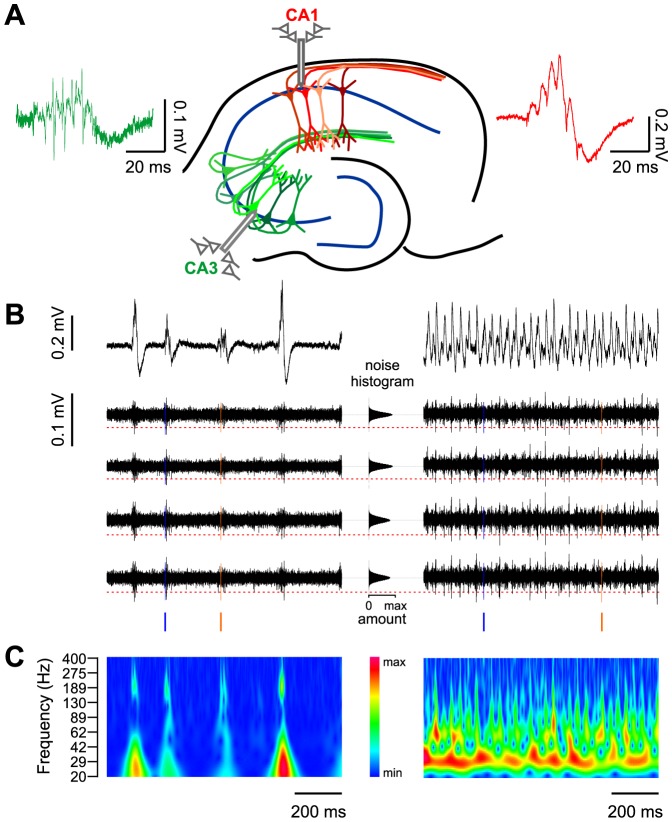
Different network states and corresponding unit activity can be analyzed in the in vitro model.
A: Schematics of recording conditions. Tetrode recordings are performed in the pyramidal cell layers of CA3 and CA1. During sharp wave-ripple oscillations (SPW-R), field potentials are generated by the recurrent network of CA3 (green) and transmitted via the Schaffer collaterals to selectively activate cell assemblies in CA1 (red). Examples of field potential waveforms are shown in the respective colors. B: Example traces of field potentials recorded in CA1 during SPW-R (left panel) and gamma oscillations (right panel). Raw field potential (upper trace) and the high pass filtered (0.5–10 kHz) potential in the four tetrode channels (lower traces). Filtering reveals high-frequency multiunit activity on SPW-R and gamma cycles. Firing of two individual units extracted by waveform analysis is highlighted in orange and blue. Time points of firing relative to the field potential are visualized by vertical ‘ticks’. The middle panel illustrates the detection criterion for unit events: horizontal histograms of all data points show largely normal distribution around zero. Events are detected if they exceed 4.5 times the standard deviation as indicated by the dashed red line. C: Wavelet spectrograms of the example traces from B. Sharp waves are superimposed by high-frequency ripple oscillations (∼200 Hz, left panel). The carbachol-induced gamma state consists of a continuous oscillation at ∼30 Hz.